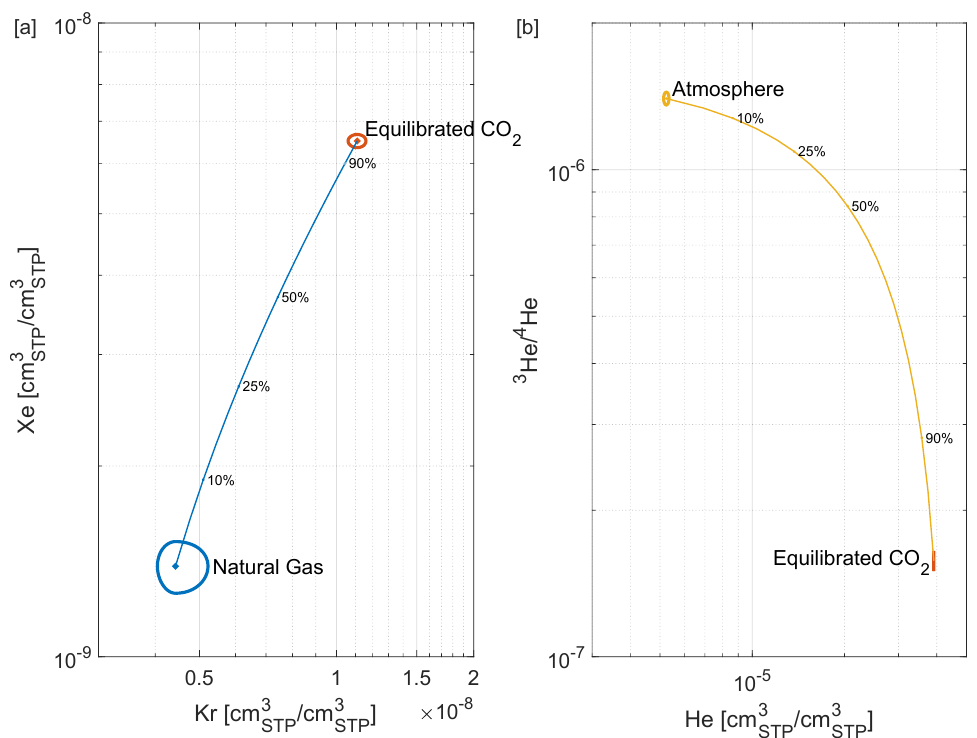
Figure 3. Increasing the dimension of included isotopes/ratios increases differentiability. ( a ) Mixing with natural gas using both Kr and Xe. ( b ) Mixing with the atmosphere including 3 He/ 4 He. The mean concentration is surrounded by the respective error